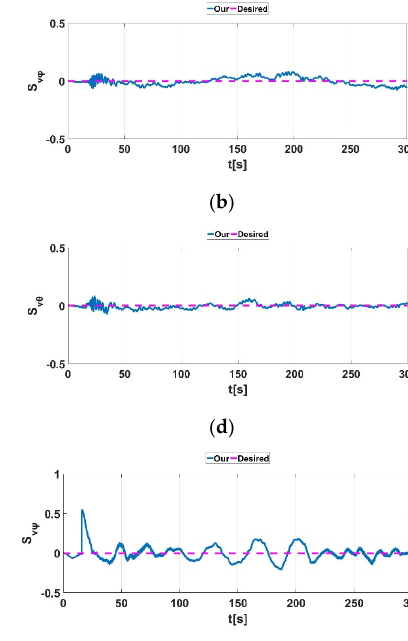
. ( a ) S vx ; ( b ) S v ϕ ; ( c ) S vy ; ( d ) S v Θ ; ( e ) S vz ; ( f ) S v ψ (cid:101) v